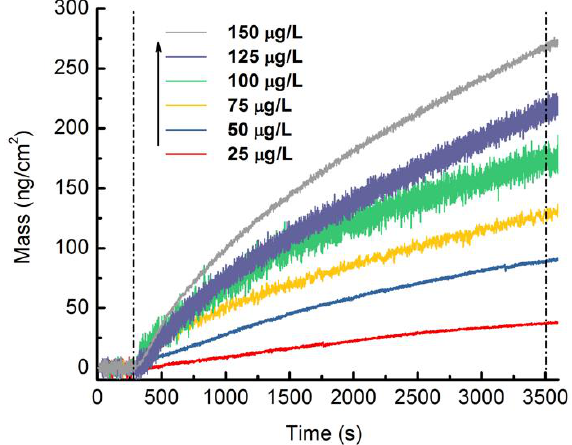
Figure 7. Changes in mass of the quartz crystal microbalance with dissipation monitoring sensor coated with molecular imprinted polymer at different methylene blue concentrations.